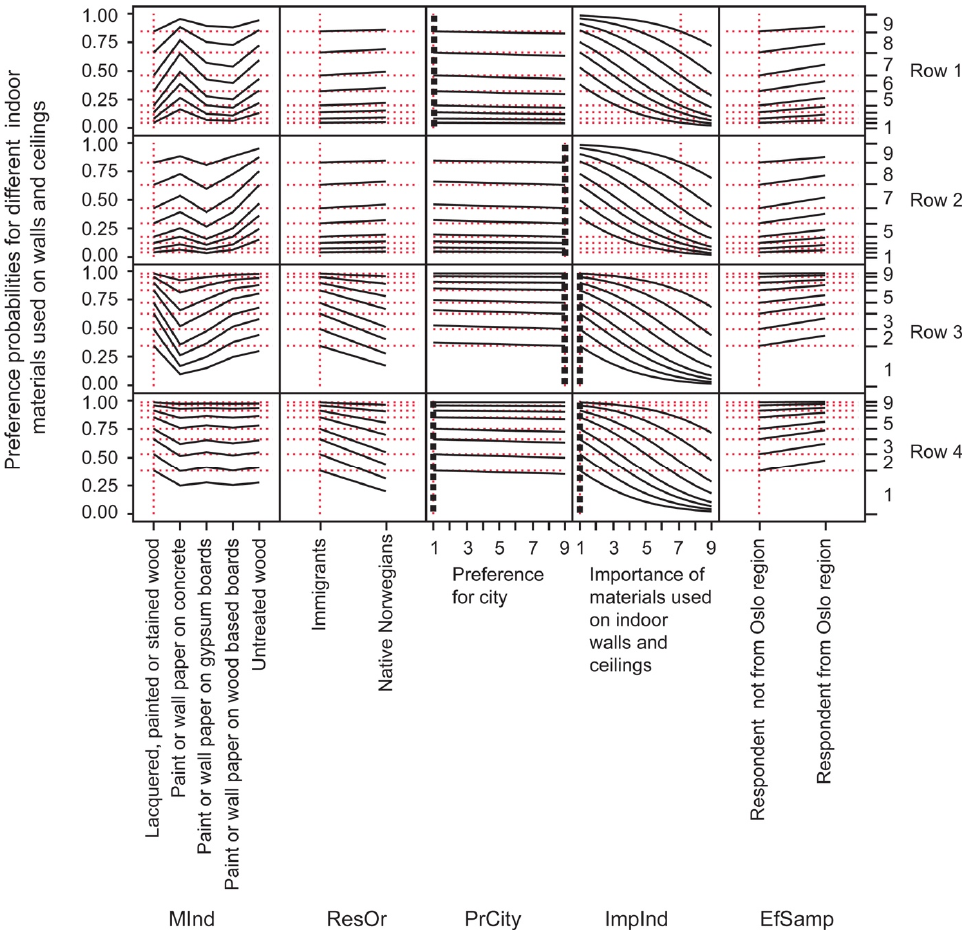
Figure 5. Profile plots showing the preferences for different indoor materials, which depend on the values of the different independent variables in Model 3. The four rows of plots are included in the figure to show how the preferences for the different indoor materials change with changes in independent variables. This figure text is partly the same as that in Figure 3 in the article of Høibø et al.